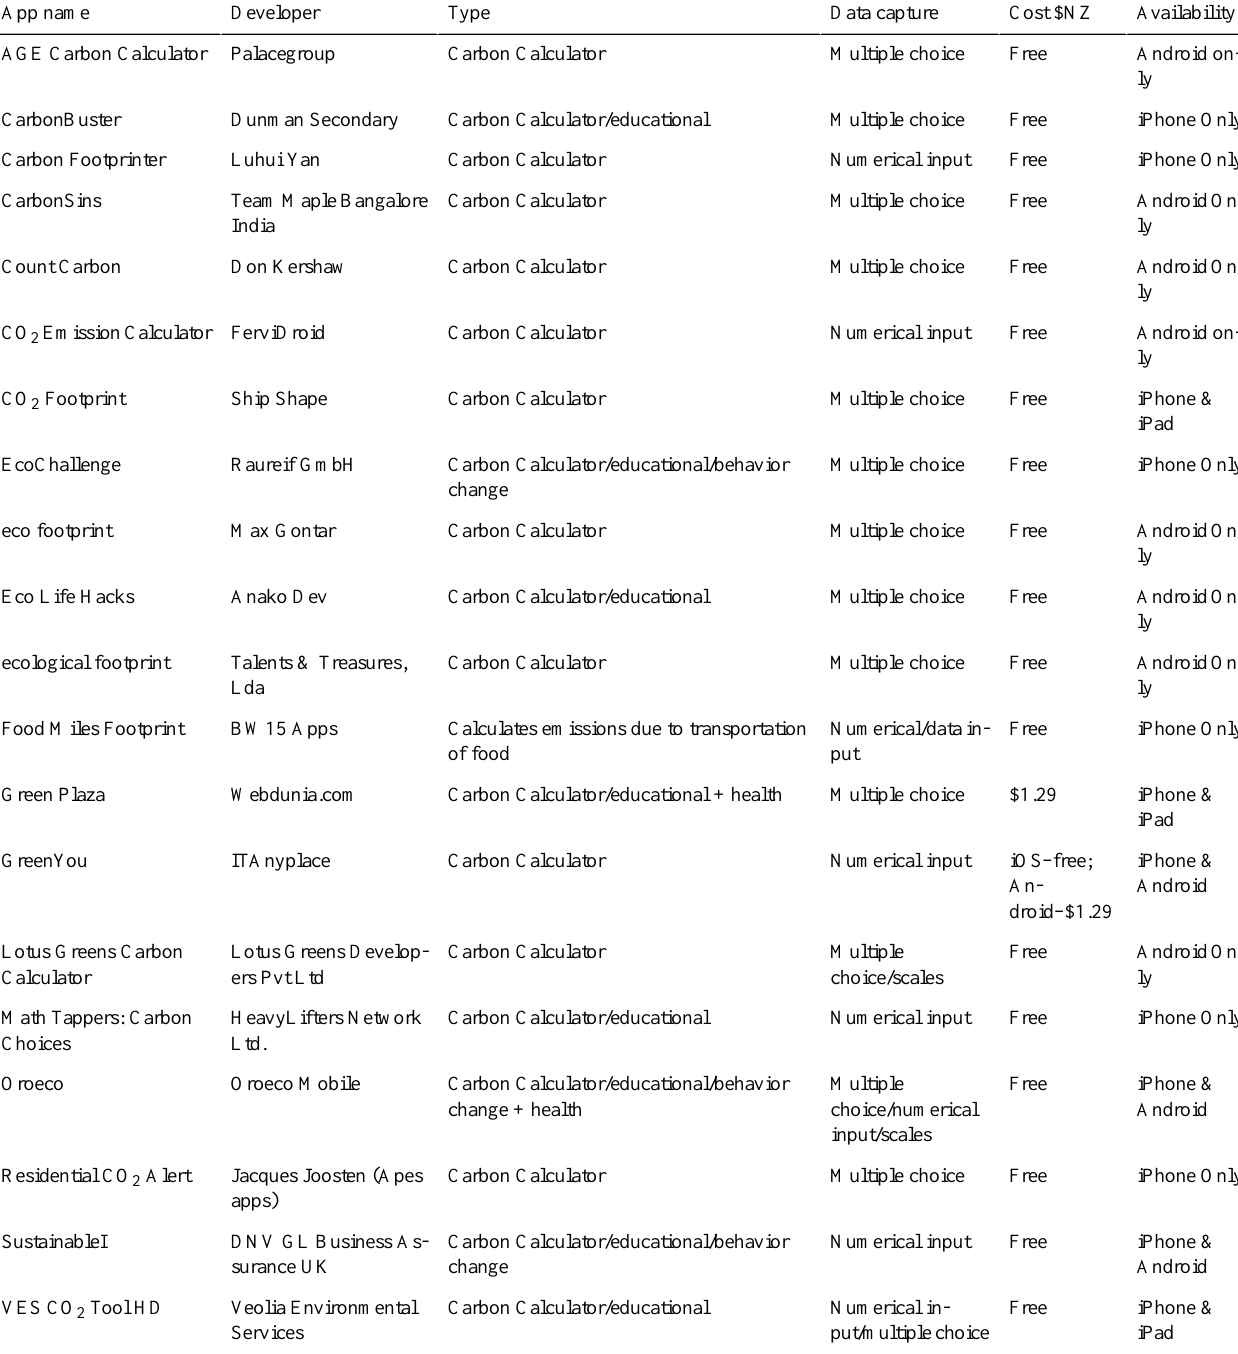
Table 4. App name, developer, type of app, method of data capture, cost, and availability of diet-related